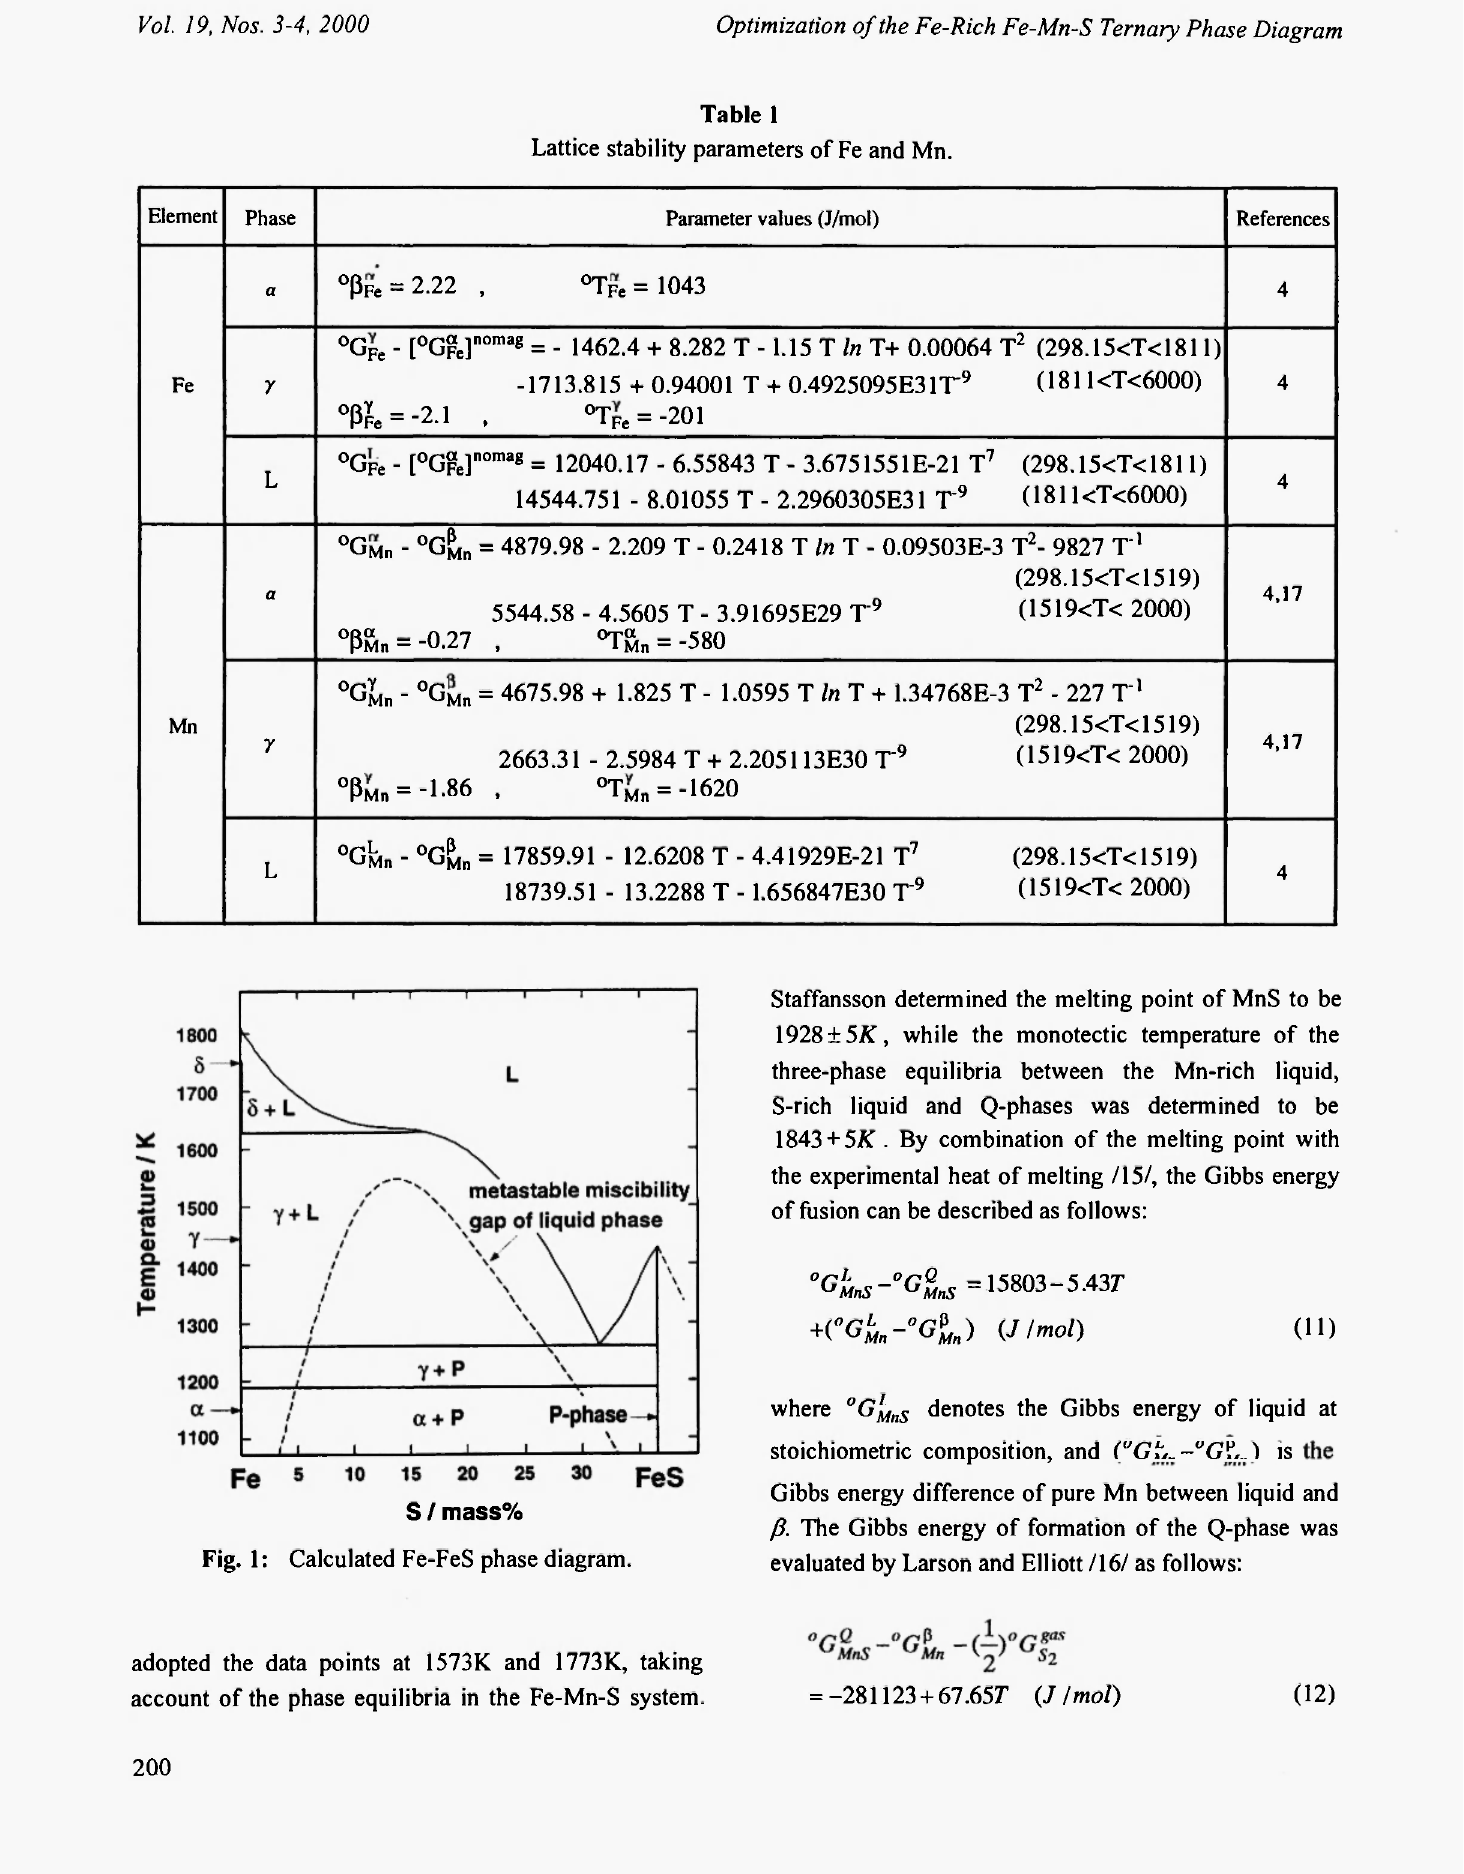
Lattice stability parameters of Fe and Mn.